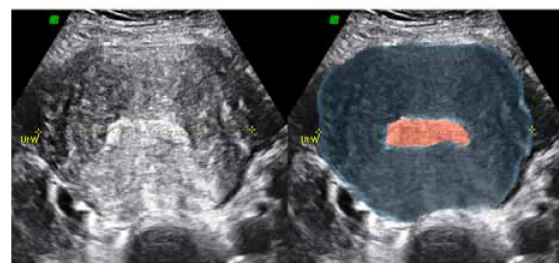
Figure 2. Transverse view of the uterus obtained transabdominaly 48 hours after CS. Ut-W, uterine width.